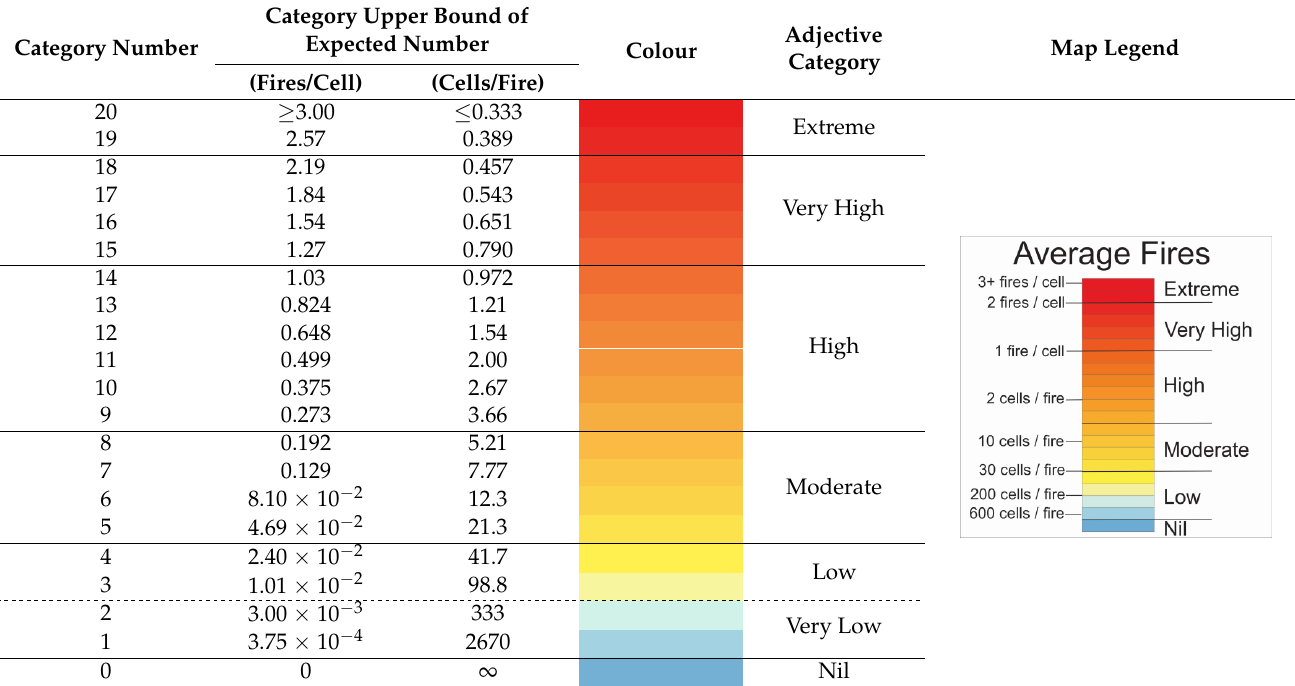
Table 6. Categories and colours used for mapping fire occurrence prediction model outputs. Note that the map legend has a highly simplified integer scale and broad adjective categories.